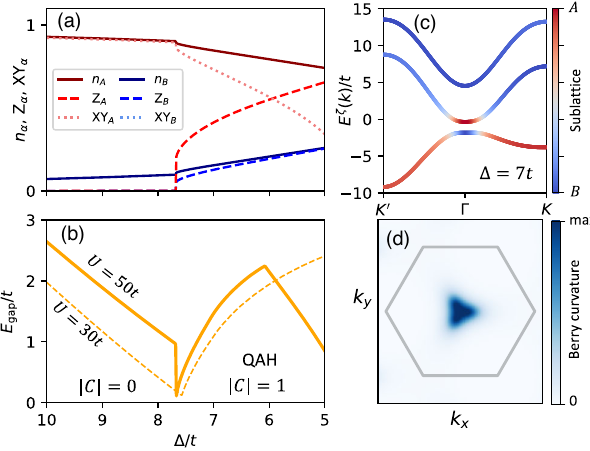
FIG. 2. (a) Order parameters and (b) charge gap obtained from the self-consistent HF Hamiltonian as a function of Δ , for 1 0 , ϕ − ½ð 2 π Þ = 3 (cid:3) , and t t t , ϕ parameters t 2 A ¼ B ¼ AB ¼ A ¼ B ¼ U ¼ 50 t . There is a transition from the xy AFM phase to the noncoplanar QAH phase with Chern number j C j ¼ 1 as Δ is reduced. The gap is also shown for U ¼ 30 t . (c) Quasiparticle band structure, with shift ζ ¼ − , obtained from the HF Hamil- tonian at Δ ¼ 7 t . (d) Berry curvature of the filled topological